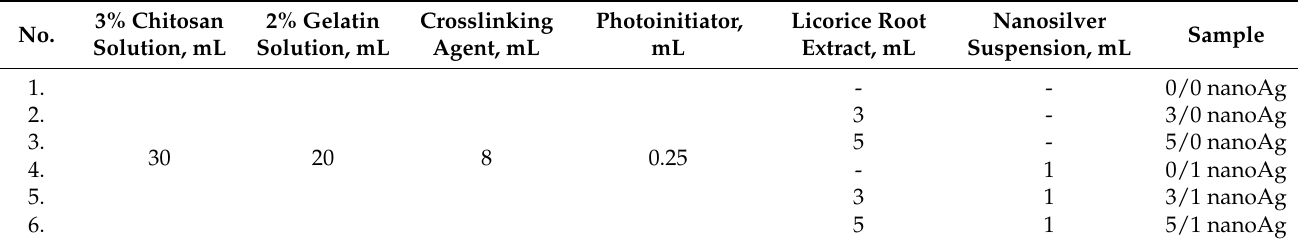
Table 6. Compositions of prepared